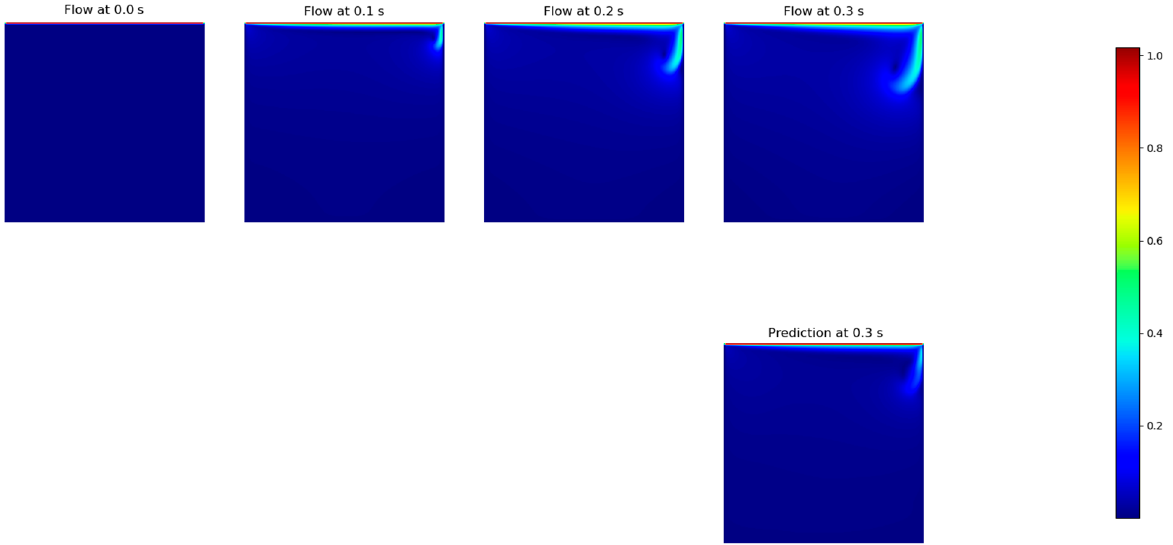
Figure 5. Flow velocities obtained by the FNO model after tuning, for t = 0.3 s. Table 1. RMSE obtained by all optimized model architectures after 50 epochs.